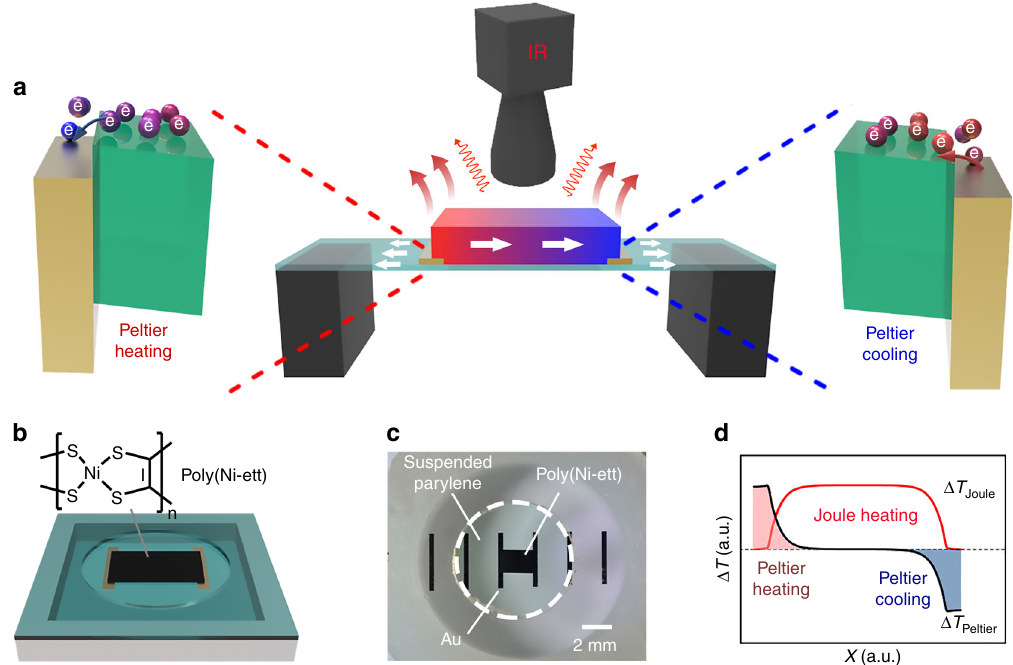
Fig. 1 Mechanism of Peltier effect and device geometry. a A schematic illustration of the Peltier effect and other involved thermal processes in a thin- fi lm thermoelectric (TE) device with lateral structure. Peltier effect, Joule heating, internal heat transfer within TE fi lm, interlayer heat conduction to the substrate, heat convection to the air, and thermal radiation occurs concurrently in the device. b A schematic illustration of the organic TE (OTE) device on the suspended parylene fi lm and the molecular structure of poly(Ni-ett). c Photograph of an OTE device on a 300 nm suspended parylene fi lm. d A schematic illustration of the temperature distribution caused by Joule heating and by the Peltier effect. Electrical cooling and heating at the different electrode/TE contacts enable the device to function as a heat engine for solid-state cooling